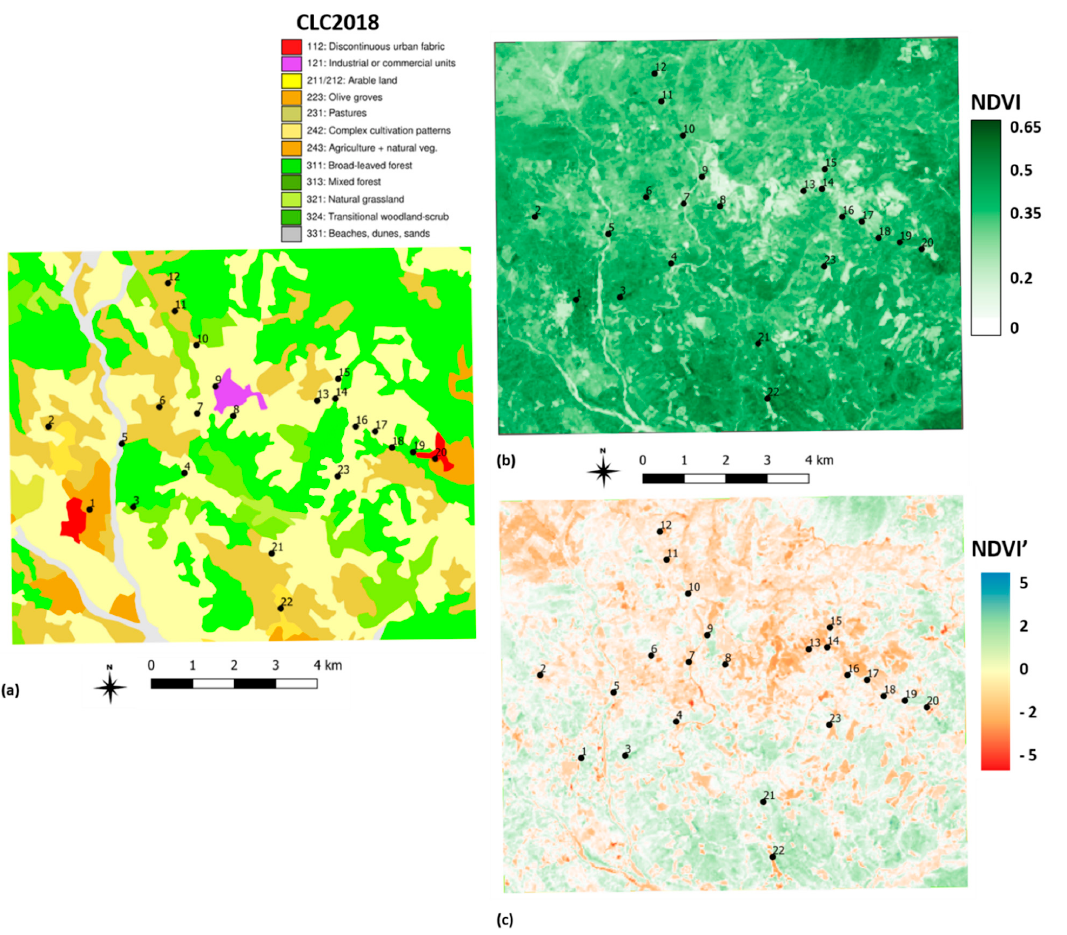
Figure 3. ( a ) CLC2018, ( b ) NDVI values and ( c ) NDVI’ values. All the maps show the sampling points overlapped. The numbers 1–23 represent the sampling points.